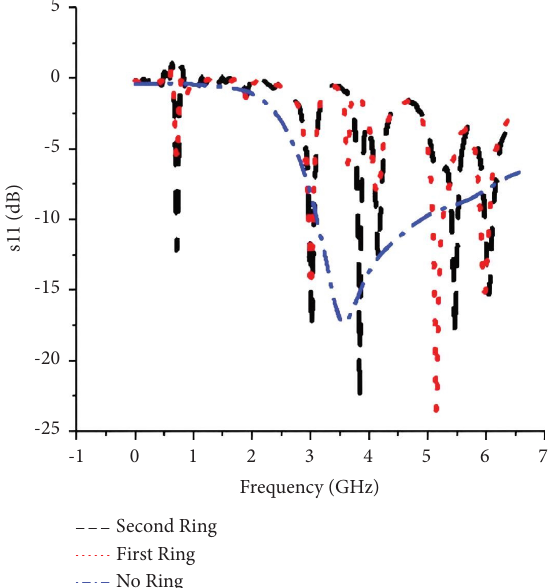
Figure 5: S 11 comparison plot for various values of ring width.